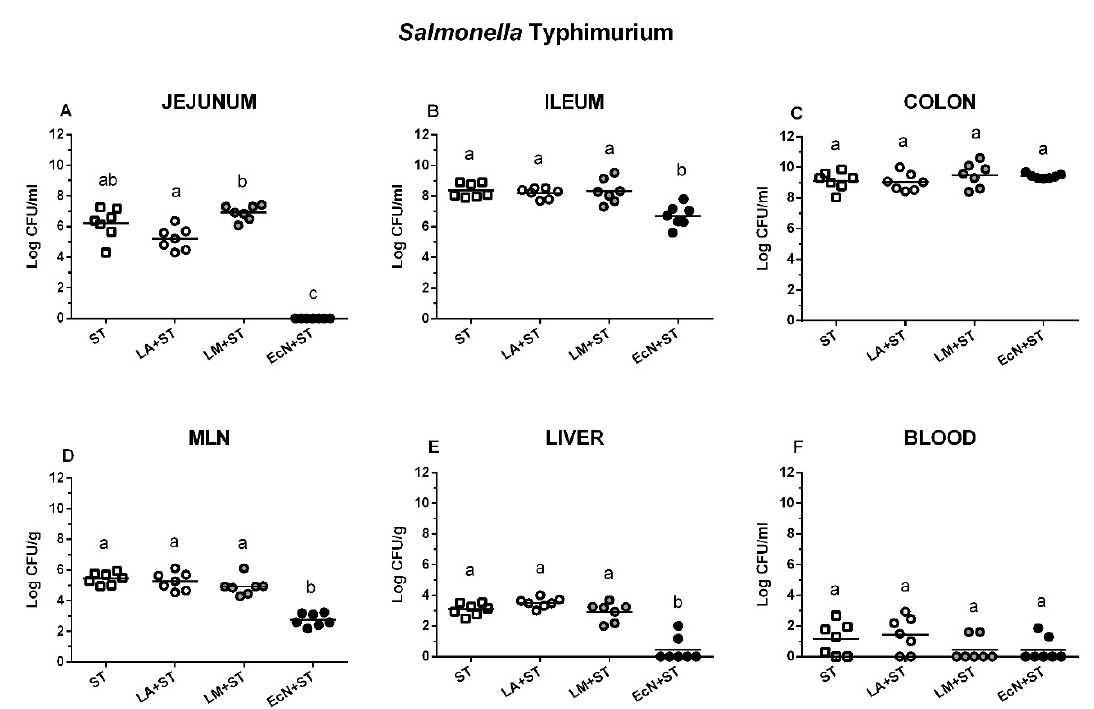
Figure 3. S. Typhimurium counts in the intestine, mesenteric lymph nodes, liver, and blood. S . Typhimurium (ST) colony forming units (CFU) were counted in the jejunum ( A , proximal jejunum), the ileum ( B ), the colon ( C ), mesenteric lymph nodes (MLN; ( D )), the liver ( E ), and blood ( F ). S . Typhimurium (ST) and its interferences with L. amylovorus (LA+ST), L. mucosae (LM+ST), and Escherichia coli Nissle 1917 (EcN+ST) were evaluated by one-way ANOVA with Tukey’s multiple comparisons post-hoc test. Statistical differences were marked by a letter system at P ˂ 0.05. The same letter means no statistical significance. Log CFU are depicted as individual spots with mean as a horizontal line and n = 7 for all groups.